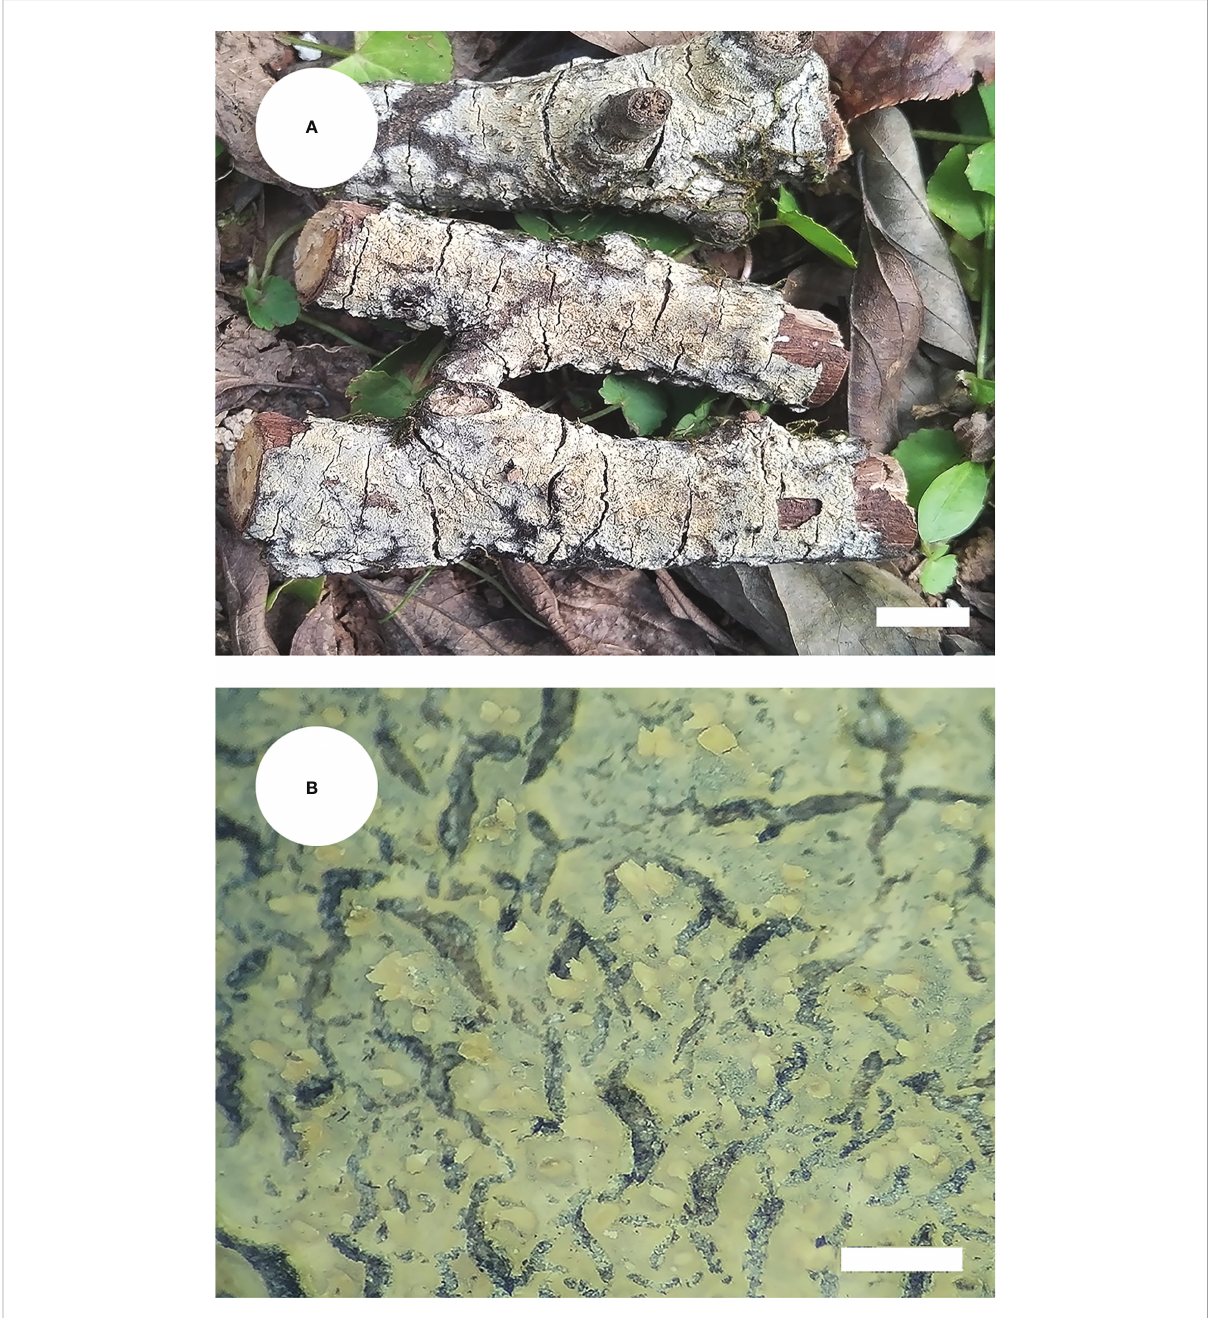
FIGURE 3 Basidiomata of Steccherinum fi ssurutum (holotype). Bars: (A) 1 cm; (B) 0.5